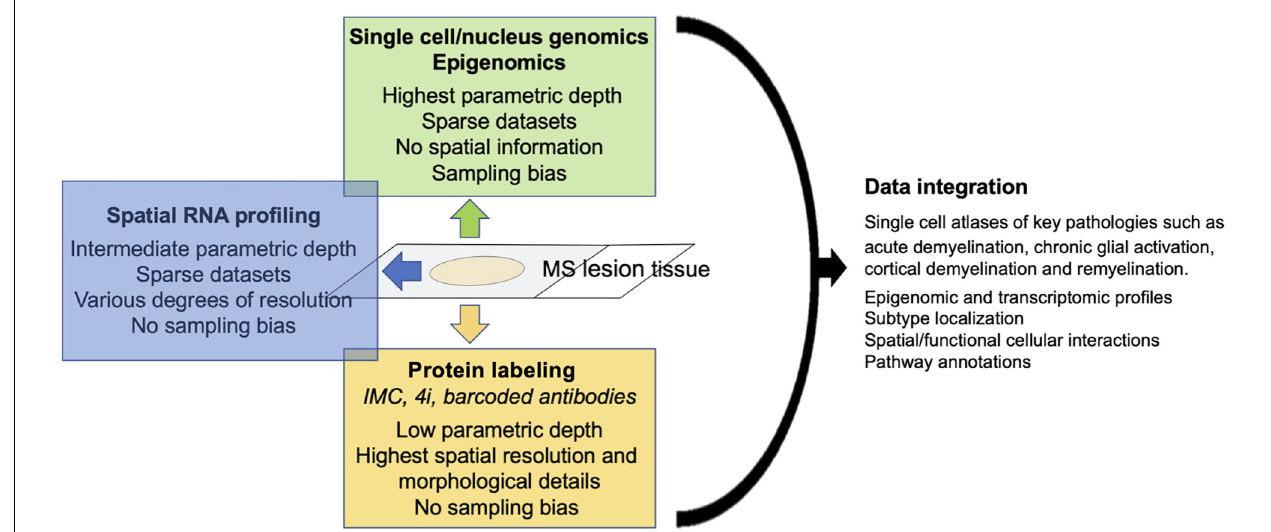
FIGURE 1 | Schematic of strengths/weaknesses of single cell technologies and data